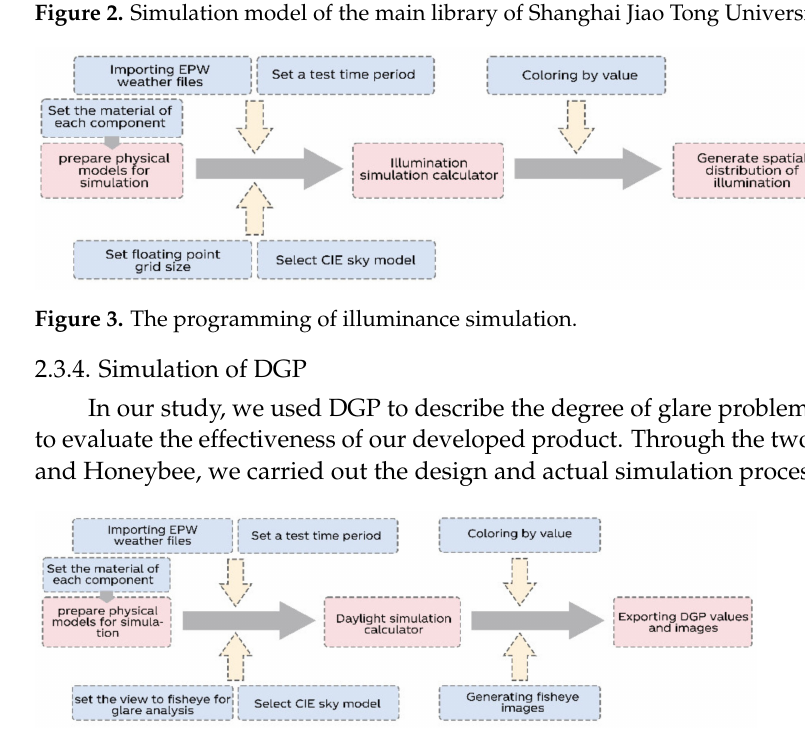
Figure 4. The programming of the DGP